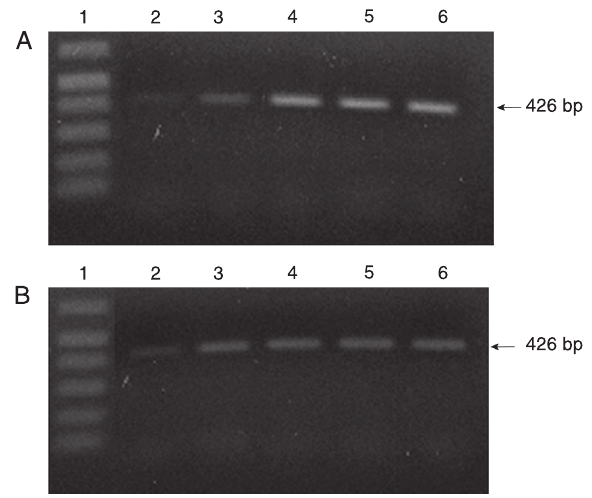
Figure 4. RT-PCR analysis of β2 integrin in embryonic chicken hearts. RT-PCR analysis of β2 integrin subunit expression was performed using total RNA isolated from whole embryonic chick- en hearts (A) or dissected atrioventricular canal regions (B). Lane